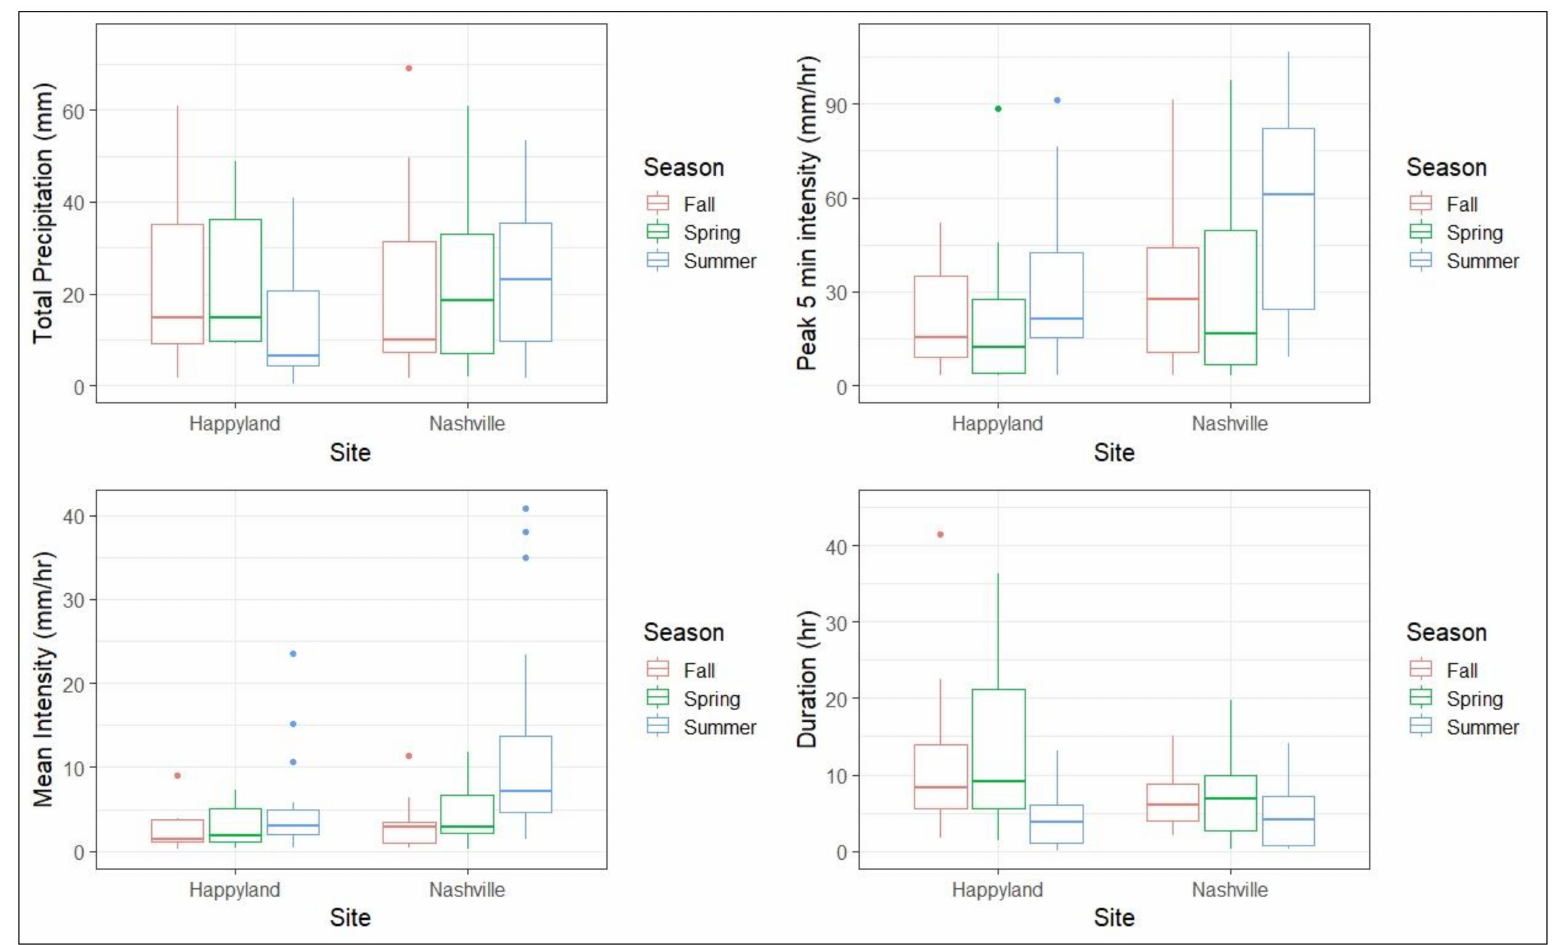
Figure 3. Precipitation characteristics for Happyland and Nashville sites based on common 52 events that occurred during the monitoring period. (Happyland # of events = 14 Spring, 21 Summer, 17 Fall and Nashville # of events = 9 Spring, 26 Summer, 17